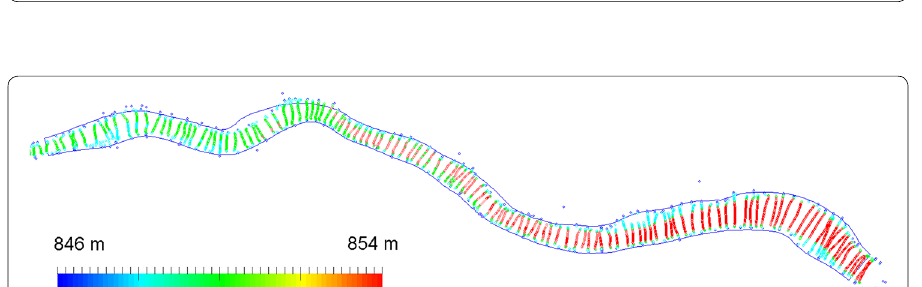
Fig. 8 Time series of downstream water level and outflow discharge during the flushing event and used for the simulations [4], modified)